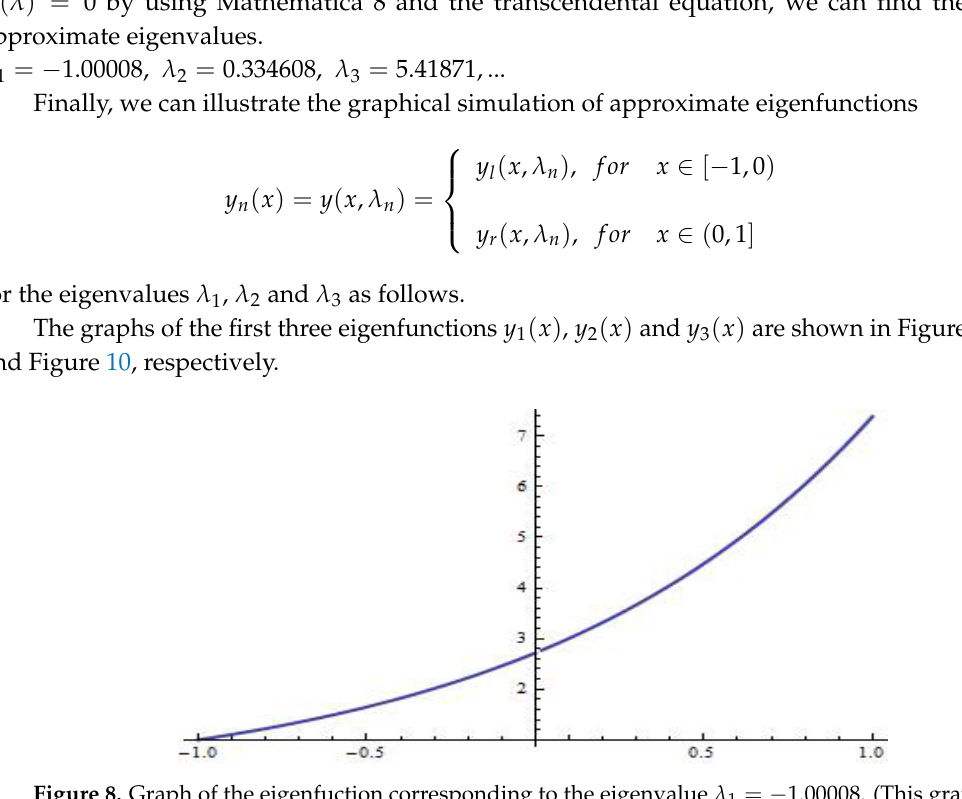
Figure 8. Graph of the eigenfuction corresponding to the eigenvalue λ 1 = − 1.00008. (This graph was sketched by using “Mathematica